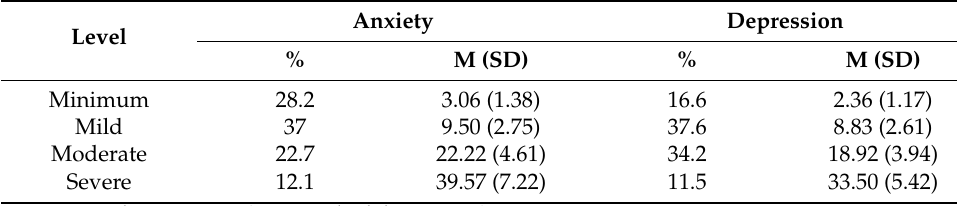
Table 2. Levels of anxiety and depression in caregivers ( N =